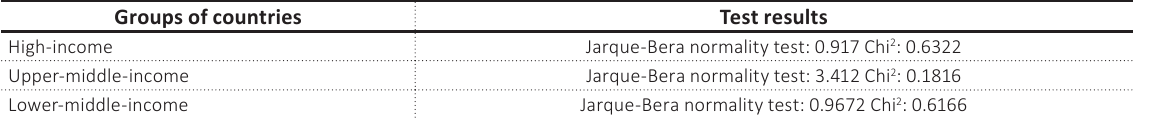
Table А3. Jarque-Bera normality test